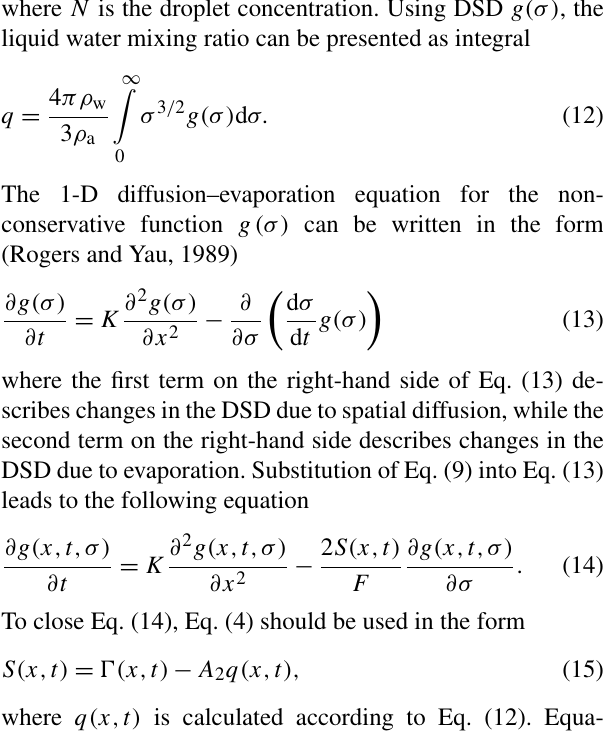
Figure 2. An example of (cid:48)(x,t) evolution during mixing.